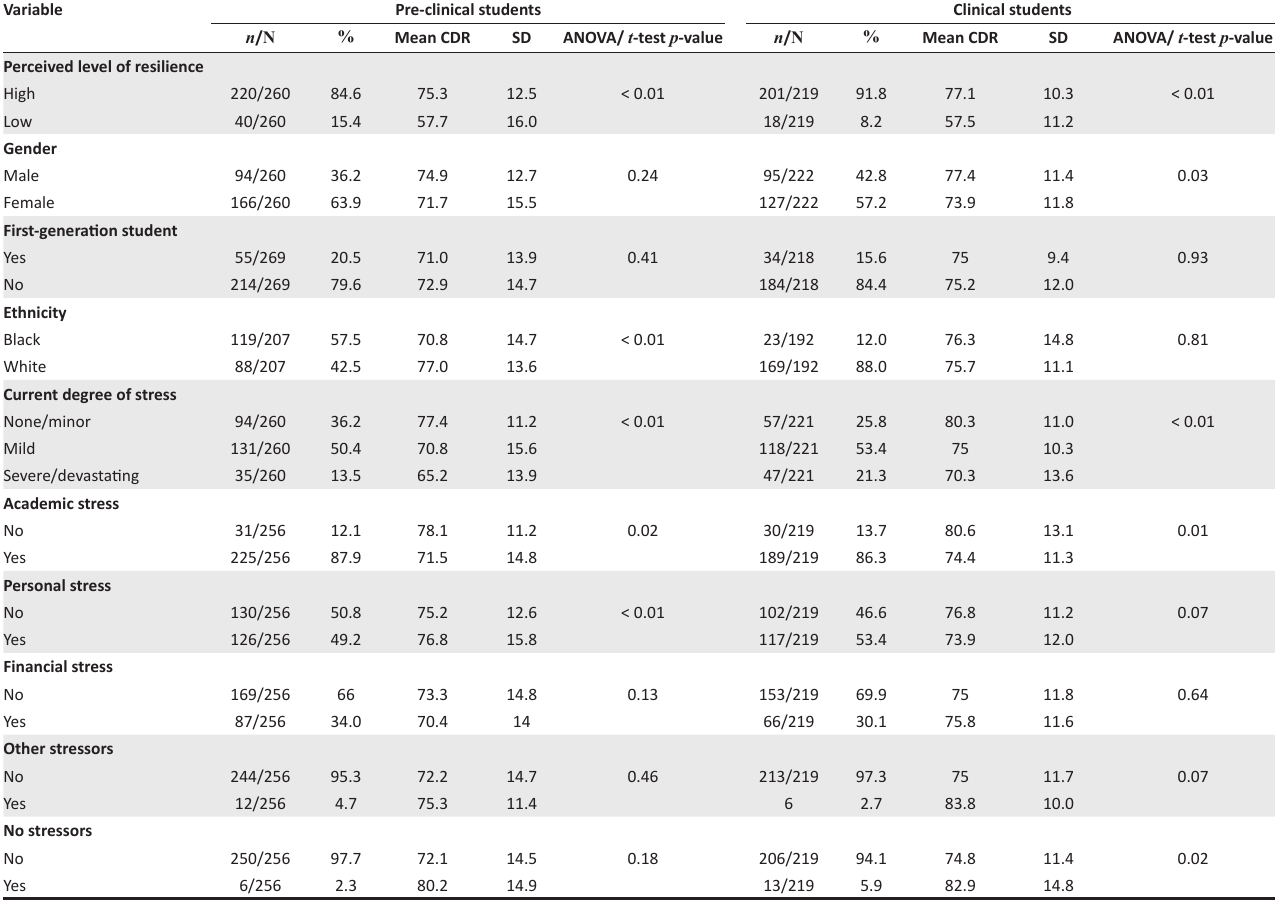
TABLE 1: Resilience scores and associated factors of pre-clinical and clinical medical students.